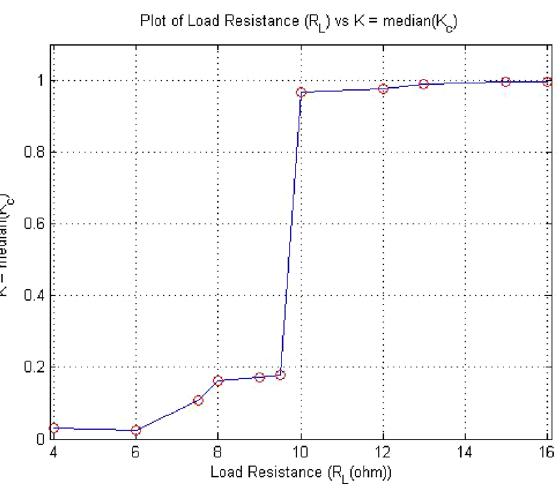
Figure 6. R L vs K plot of 0-1 test for forward converter when R L changing from R L = 4 (cid:31) to R L = 16 (cid:31)